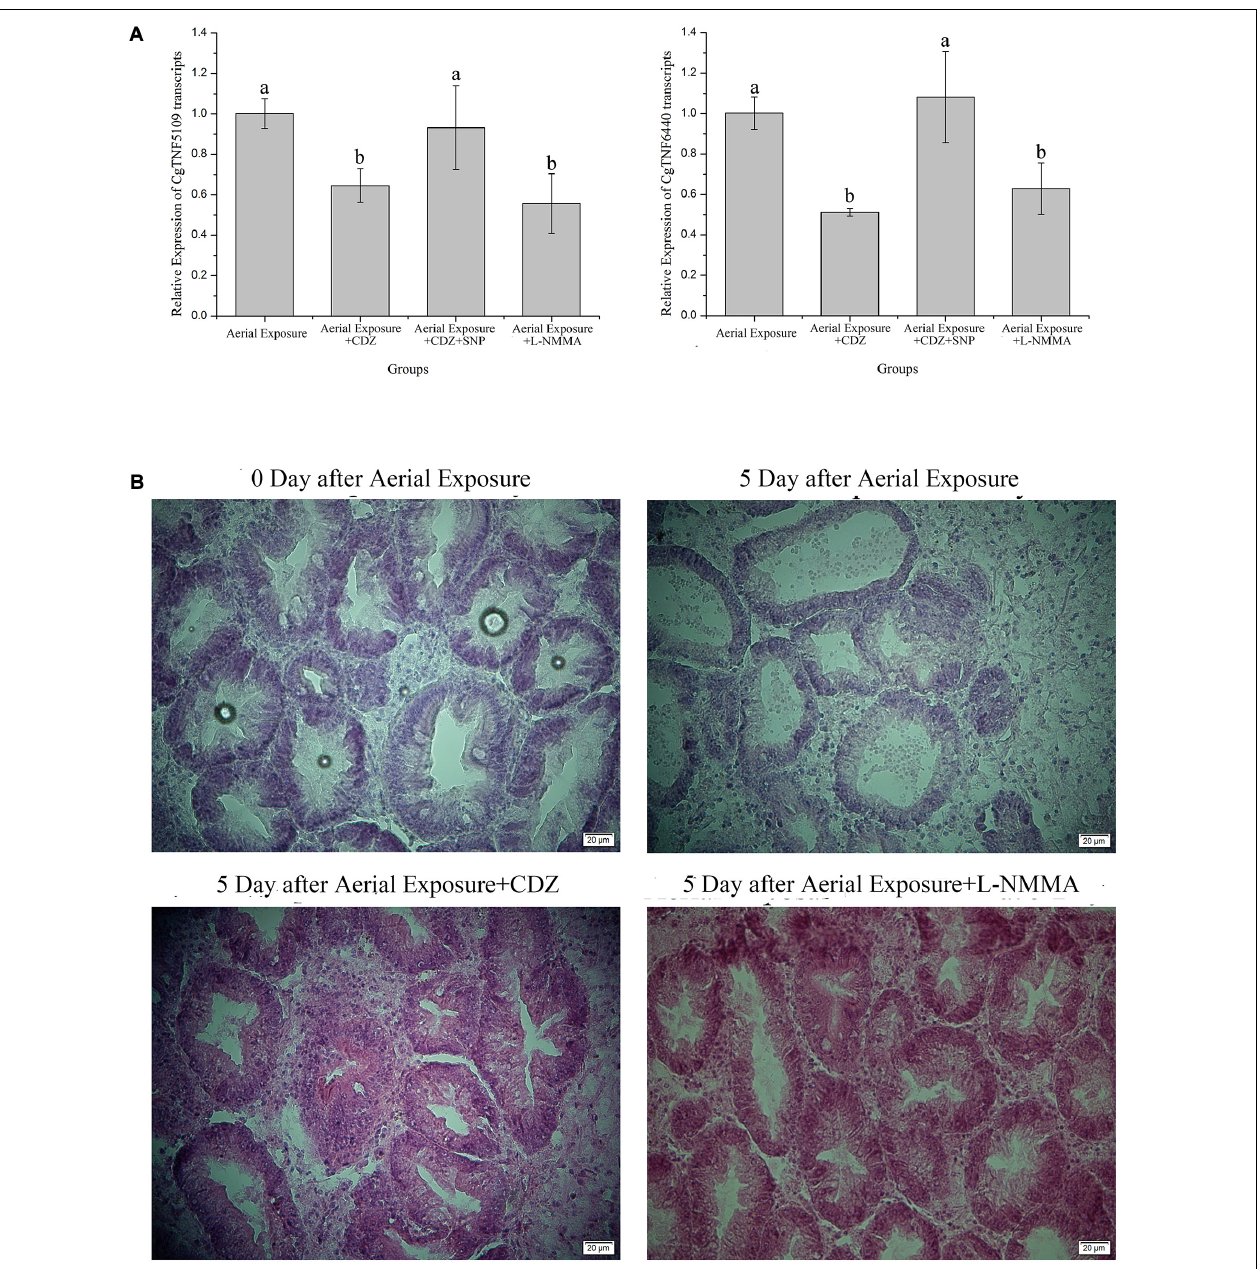
FIGURE 3 | Alternations of CgTNFs transcripts and hepatopancreas morphology after functional inhibition of CaMs and NOS. (A) Expression levels of CgTNF5019 and CgTNF6440 in oyster hemocytes after functional inhibition of CaMs and NOS during emersion. Both genes were found decreased significantly when CaMs were suppressed by CDZ or when NOS activity was repressed by L-NMMA. Transcripts of CgTNFs regained to basal level when NO donor was supplemented during CaMs inhibition. Significance was determined by one-way analysis of variance (ANOVA) and marked with letters (a, b, c, etc.) if p < 0.05. (B) Hematoxylin and eosin staining of hepatopancreas after the functional inhibition of CaMs and NOS during emersion. As shown, digestive tubules of oyster hepatopancreas were pathologically expanded after a 5-day emersion while massive vacuolization was also observed in the epithelial cells. When CaMs and NOS were repressed during emersion by continuous injection of CDZ or L-NMMA, the pathological expansion of digestive tubules along with vacuoles of epithelial cells was